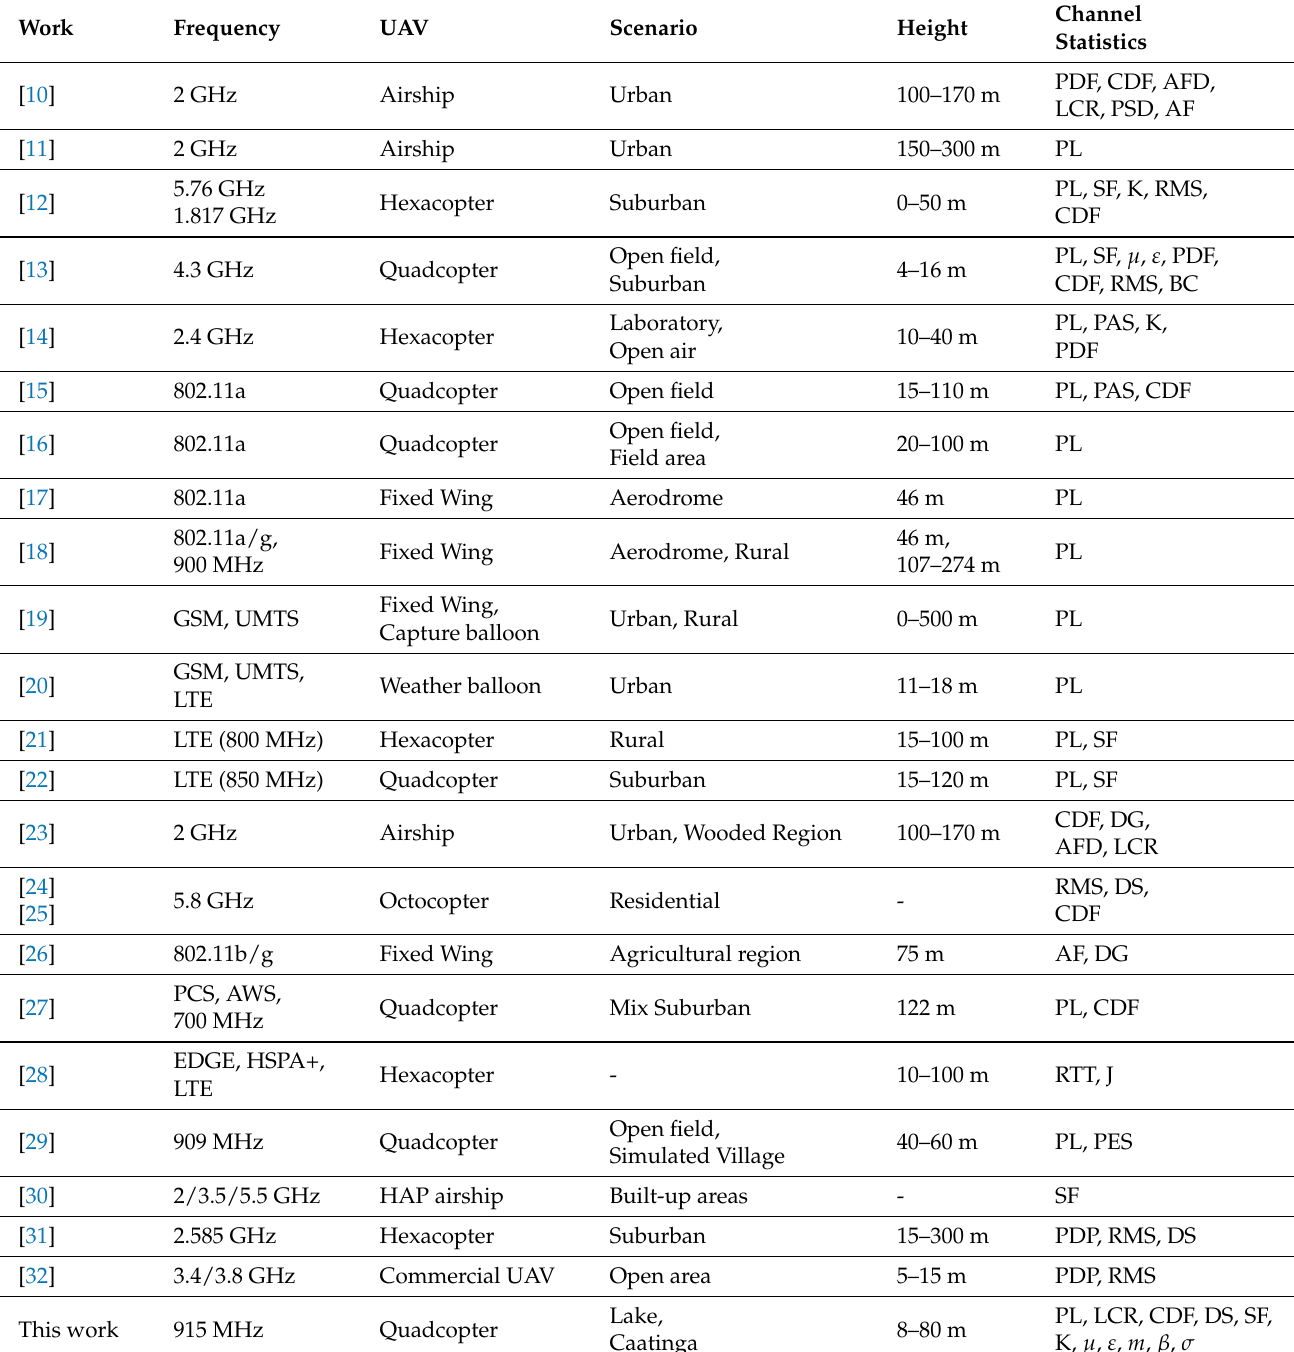
Table 1. Characterization of channels with